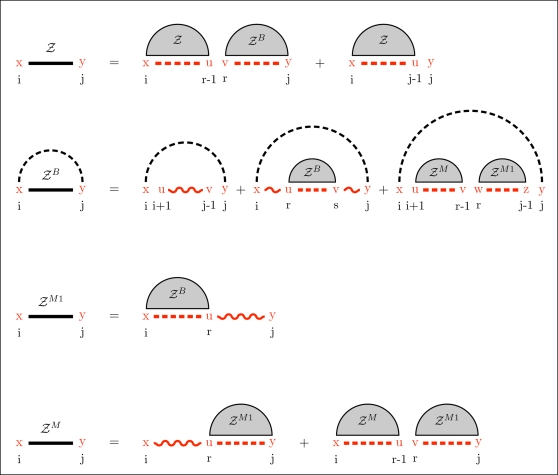
Feynman diagram of original recursions from McCaskill's algorithm [20] to compute the partition function and extension (in red) to RNAmutants recursions.Sequence index are given below the diagram. Shaded half-disks represent secondary structures with at least one base pair and correspond to recursive calls of the partition function computations. The labels give the type of the recursion. The dashed arc lines represent base pairs. The extensions brought by RNAmutants to the McCaskill recursions are highlighted in red and address the labeling of the mutant sequence. The distribution of the mutations is determined using the recursive equations described in the section Partition Function for Mutant RNA in Methods. Wavy lines represent ensembles of sequences with a fixed number of mutations and an empty secondary structure. While dashed lines are mutant sequences to be recursively determined.